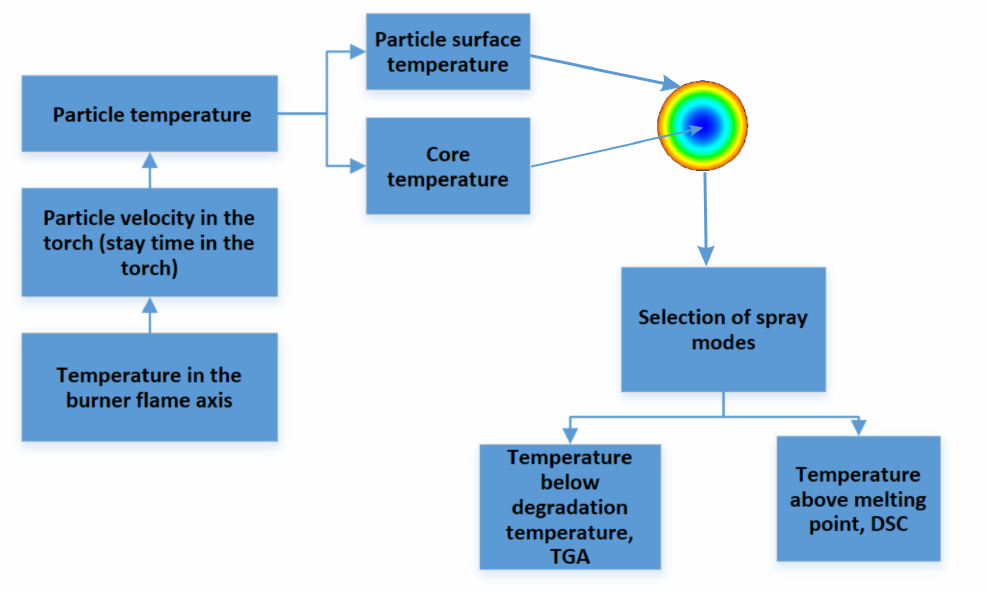
Figure 8. Spray mode selection